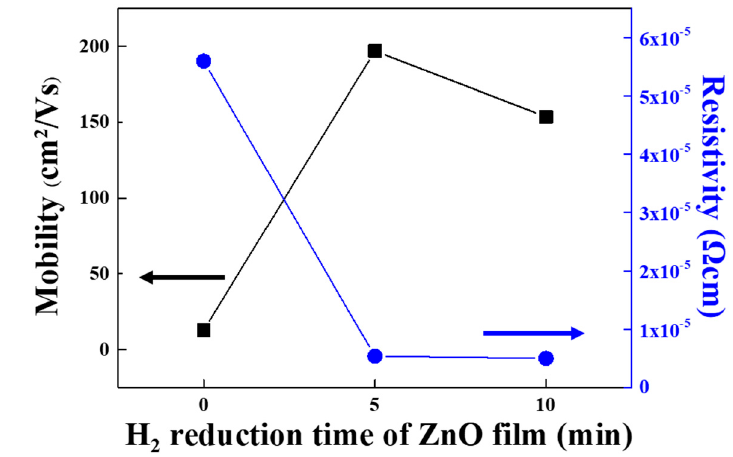
Figure 5. Hall measurement analysis to confirm the electrical conductivity of the ZnO film and the ZnO NS.